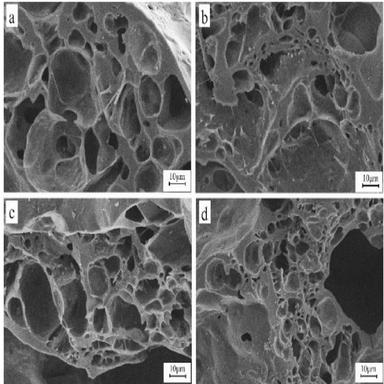
SEM micrograph of (a) C500, (b) C700, (c) C900, (d) C1100.